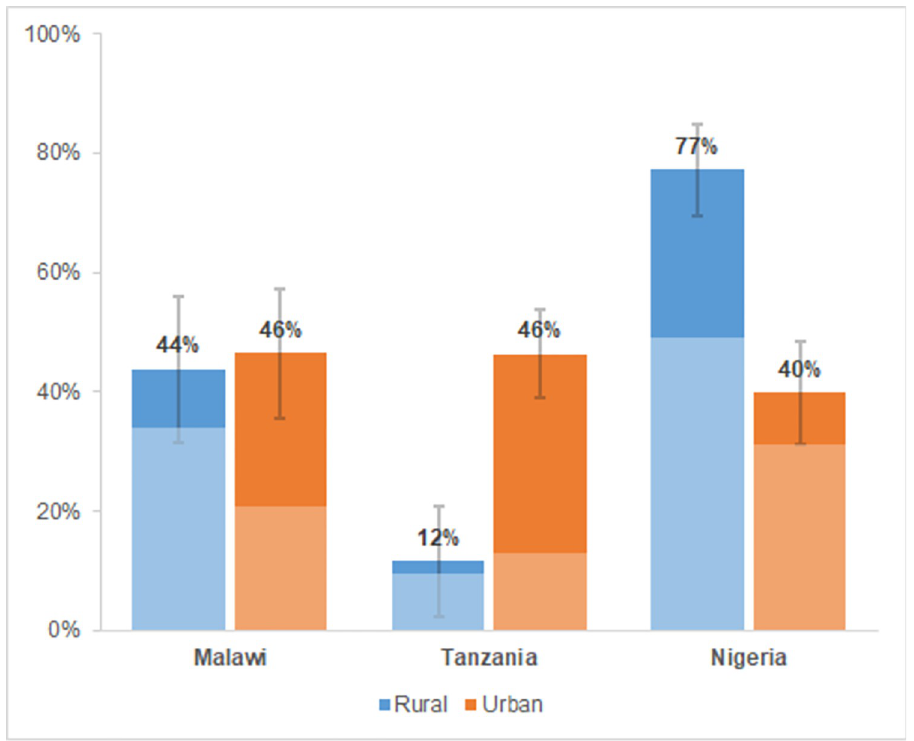
Fig 1. Average gender pay gap (in %) in non-farm employment across rural and urban areas in Malawi, Tanzania and Nigeria for women and men aged 25–55. The lighter (darker) area represents the part that is explained by differences in characteristics (returns). Error bars represent standard errors of the mean. Results are obtained from regressions presented in Table 4. Population statistics are corrected using sampling weights. The number of observations for the different bars are as follows: 3,156; 2,593; 1,592; 1,814; 2,285;